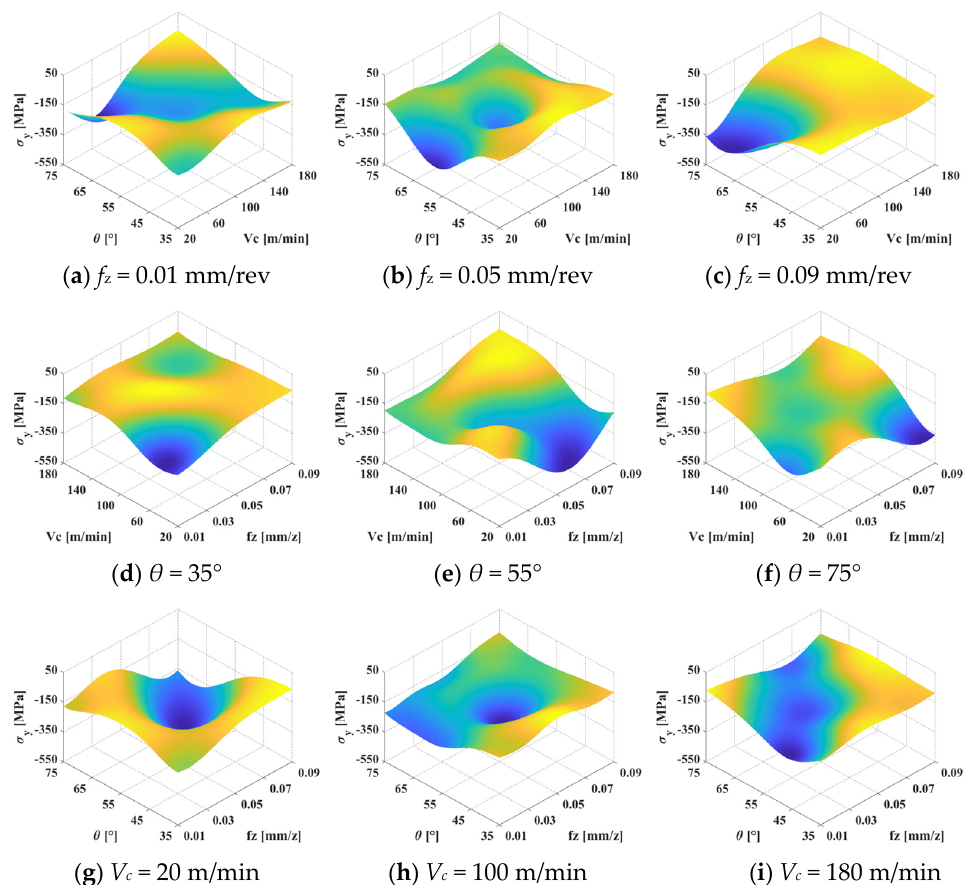
Figure 13. Interactive effects of machining parameters on surface residual stress in the σ y direction.